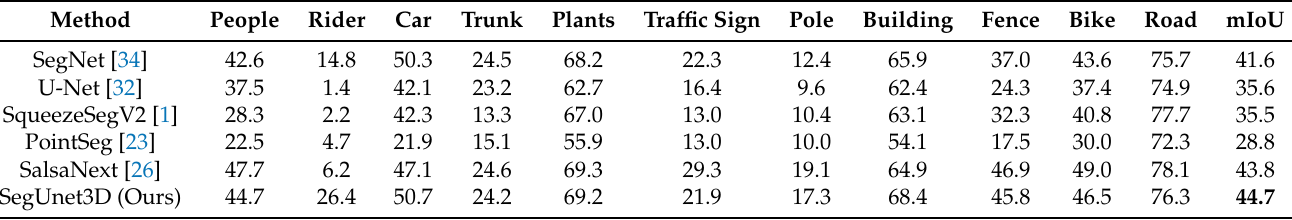
Table 7. Evaluation results on the SemanticPOSS dataset. The values are in %. The highest mIoU value is shown as